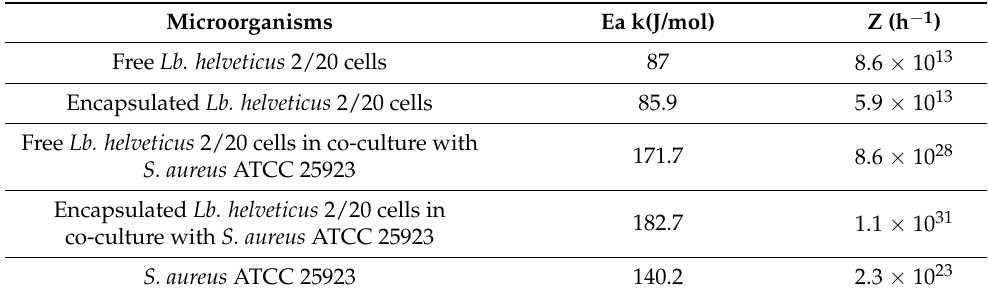
Table 4. Activation energy of growth and pre-exponential multiplier in the Arrhenius equation for Lb. helveticus 2/20 and S. aureus ATCC 25923 in chocolate